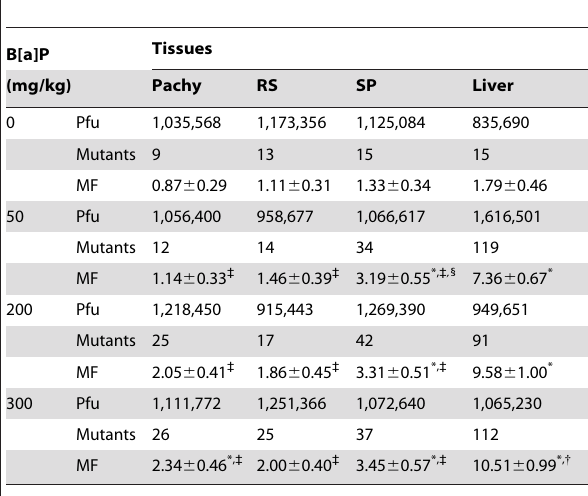
Pfu, plaque-forming unit; MF, mutant frequency; Pachy, pachytene spermatocytes; RS, round spermatids; SP, epididymal spermatozoa. *Significantly (P , 0.05) different from 0 mg/kg, same cell type. { Significantly (P , 0.05) different from 50 mg/kg, same cell type. ` Significantly (P , 0.05) different from liver, same dose. 1 Significantly (P , 0.05) different from pachytene spermatocytes, same dose. doi:10.1371/journal.pone.0087439.t002 PLOS ONE |